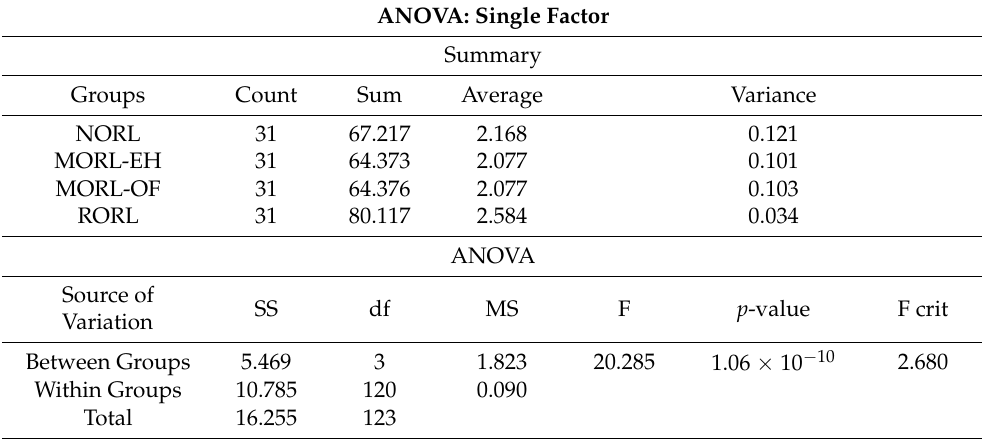
Table 8. Summary of ANOVA results from the 10-day drawdown rate. ANOVA: Single Factor